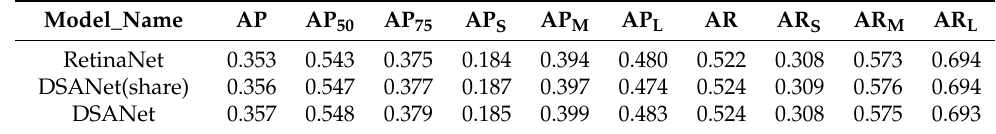
Table 2. Comparison of whether classification and localization tasks share a DSA module. DSANet(share) represents that the classification and localization tasks of DSANet share a DSA module, namely, DSA only has one branch. DSANet shows that DSA provides two different branches for classification and localization tasks. DSAnet(share) and DSANet all add DSA module in conv4-7 feature maps.